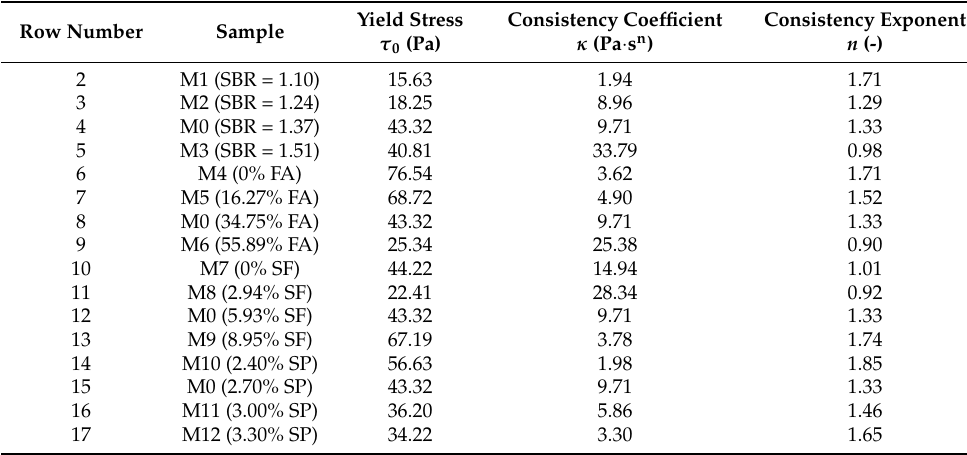
Table 3. Three parameters of mortars with different mix